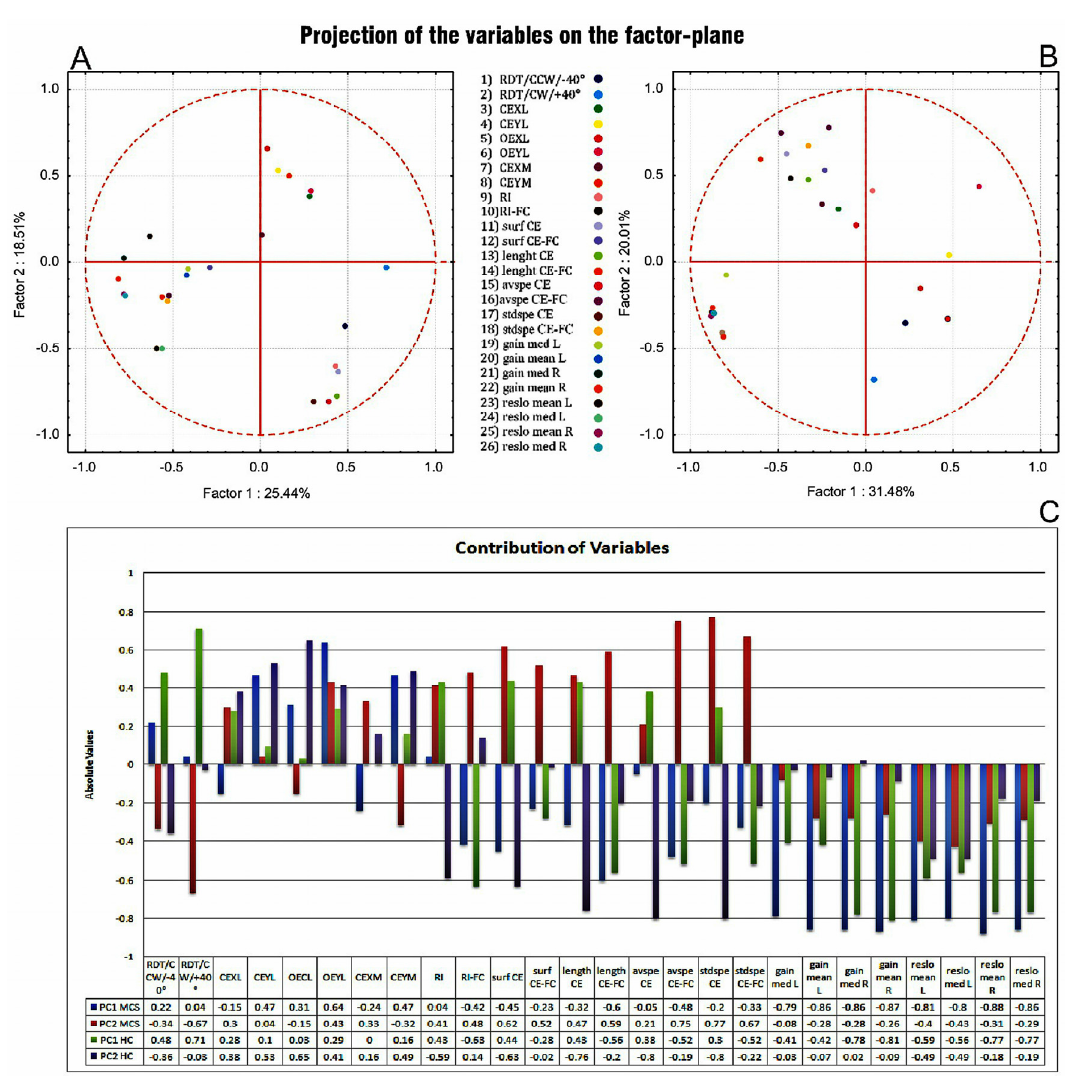
Figure 5. Component coefficient analysis showing variables projection on the factor plane (Factor 1 × Factor 2) in HC ( A ) and MCS ( B ) subjects and contribution of variables ( C ) in both groups subjects within PC1 and PC2. RDT, Rod and Disc test; CCW, counter-clockwise; CW, clockwise, CE, closed eyes; X, spectral values of body oscillations on X plane; Y, spectral values of body oscillations on Y plane; L, low frequency interval, M, middle frequency interval; surf, surface of the ellipse of confidence; avspe, mean velocity of body sways; stdspe, standard deviation of velocity of body sways; RI, Romberg index; FC, foam carpet; med, median; reslo, regression slope; L, left; R, right. In the centre of the figure, ( A ) and ( B ) legend colours; in bottom-left, legend colour of ( C ).